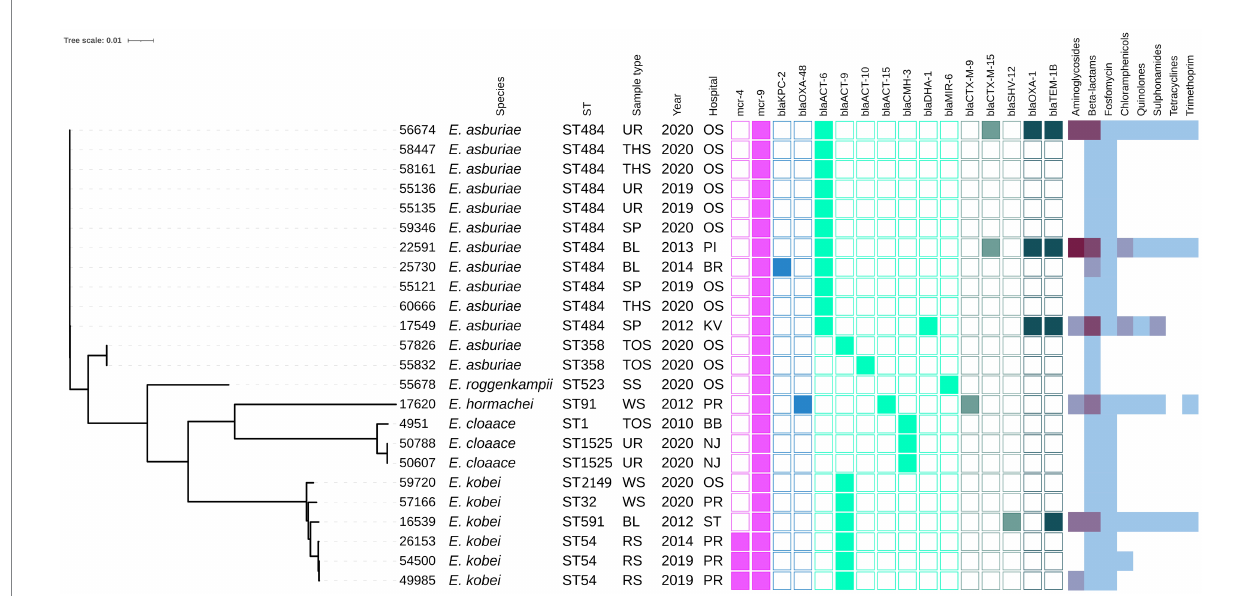
FIGURE 2 Phylogenetic tree of Enterobacter spp. isolates of Czech clinical origin. The metadata specify the species (Species); sequence type (ST), type of sample (Sample type): urine (UR), throat swab (TSH), sputum (SP), blood (BL), tonque swab (TOS), skin swab (SS), wound swab (WS), rectal swab (RS); year of isolation (Year) and city where is the hospital related to the isolate recovery (Hospital): Ostrava (OS), Pribram (PI), Brno (BR), Karlovy Vary (KV), Prague (PR), Brno-Bohunice (BB), Novy Jicin (NJ), Strakonice (ST). The color squares represent presence (full square) or absence (empty square) or respective antibiotic resistance genes divided to genes encoding resistance to colistin (pink), carbapenemases (blue) and other beta-lactamases (turquoise, see legend Figure 1). The heat map in the last section indicated the amount of antibiotic resistance genes carried by the respective isolate in specified category of antibiotics from zero (white) to maximum of five (dark